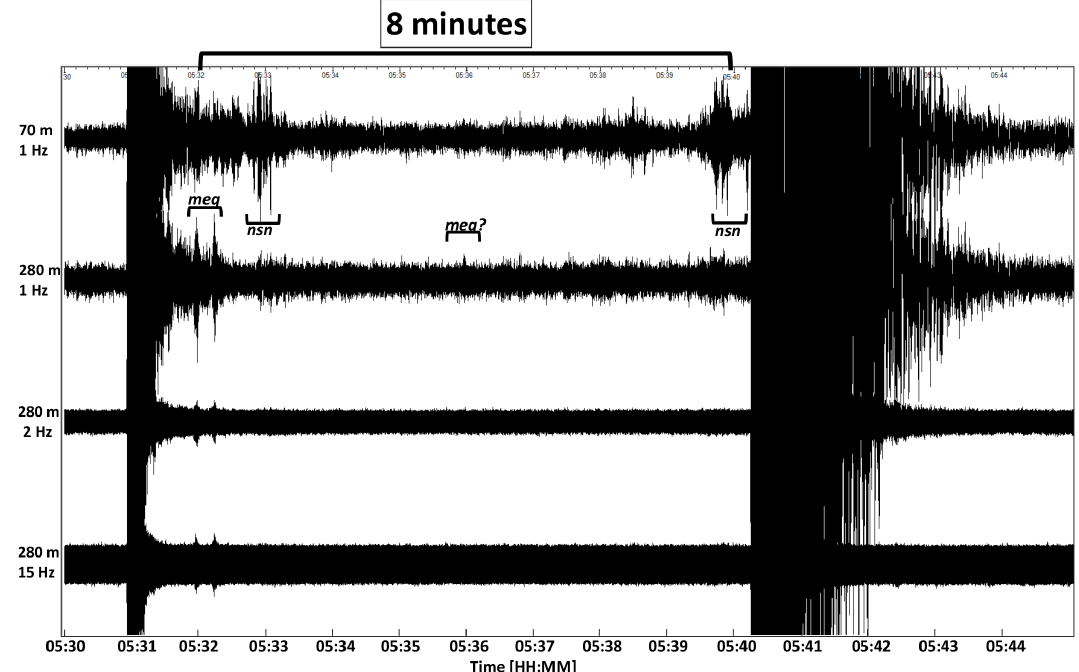
Figure 5. Vertical component seismograms of the Yalova 25 June 2016 foreshock ( ∼ 05:31) and M w 4 . 2 ( ∼ 05:40) earthquakes as recorded at the Tesvikiye (TESV) borehole station of the GONAF network. The depth and natural frequency of the TESV sensors are shown on the left. The seismograms were recorded at 500 samples/second and have a usable bandwidth of 0.1 to 200Hz. The amplitudes of each trace have been normalized to matching maximum values. The times of some near-surface noise ( nsn ) and smaller earthquakes ( meq ) are shown with upward and downward facing brackets. These two signals can be easily identified by comparing their signal-to-noise ratios ( S/N s) as a function of 1Hz sensor depth: near-surface noise ratios decrease with depth, while earthquake ratios increase. For example, the microearthquakes that took place just before and above the left end of the 8min bar are clearly evident on the ∼ 300 deep sensor, but are buried in near-surface scattering noise at ∼ 75m. The S/N for the near-surface noises just after these events is reversed: the large signals at ∼ 75m are nearly gone on the ∼ 300m sensor. In between the latter times are a number of events with roughly equivalent S/N s ( ∼ 1) at both depths. As is shown in Fig. 6, in many cases it is possible to determine their origin by comparing frequency contents at ∼ 75 and ∼ 300m. The 8min long bracket along the time axis shows the data window used for this analysis in Fig.